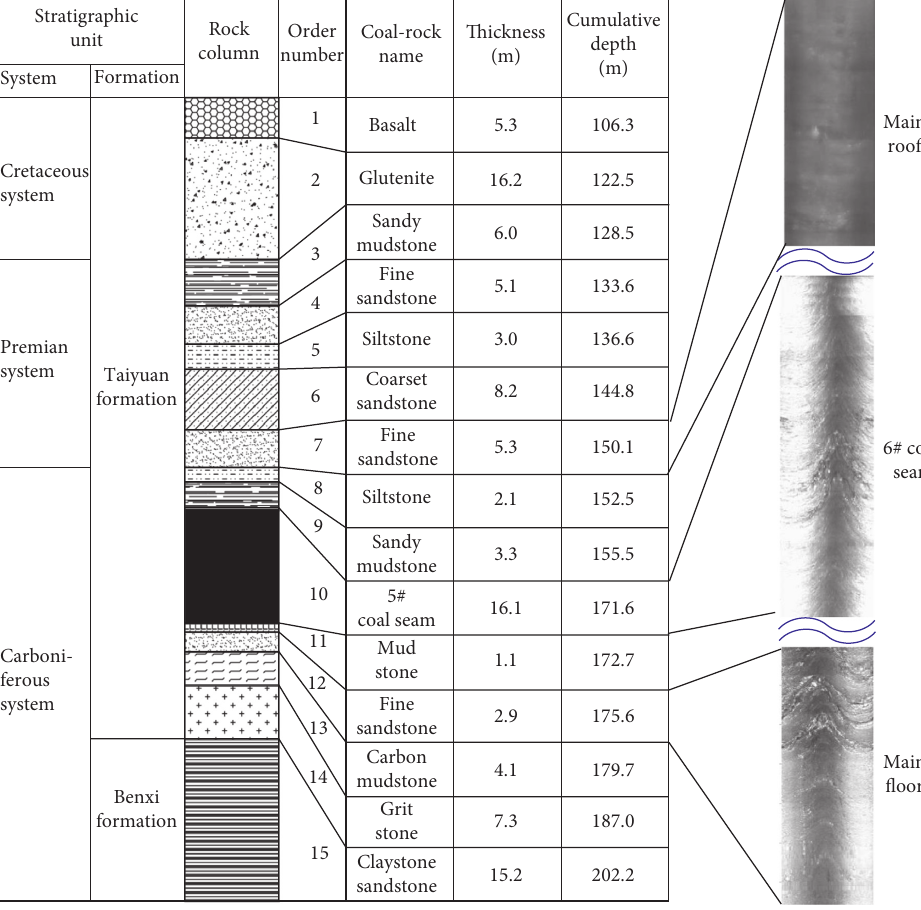
Figure 2: Generalized stratigraphic column.